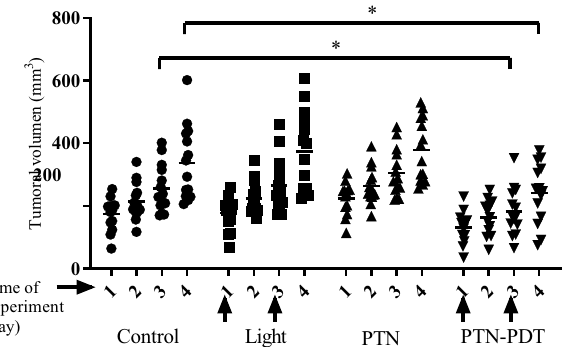
Figure 7. Delayed tumour growth after PTN-PDT. A DMSO lotion containing 1.96 mg of PTN was applied on the skin over the tumour and after 2 h the area was illuminated. This PTN-PDT treatment was repeated on days 1 and 3 of the experiment (arrows). Controls received vehicle treatment. Illumination and PTN-treated controls were also included. Tumour volume was followed by caliper measurement. *p < 0.05 control vs. PTN- PDT, two- way ANOVA, followed by Sidak’s multiple comparisons